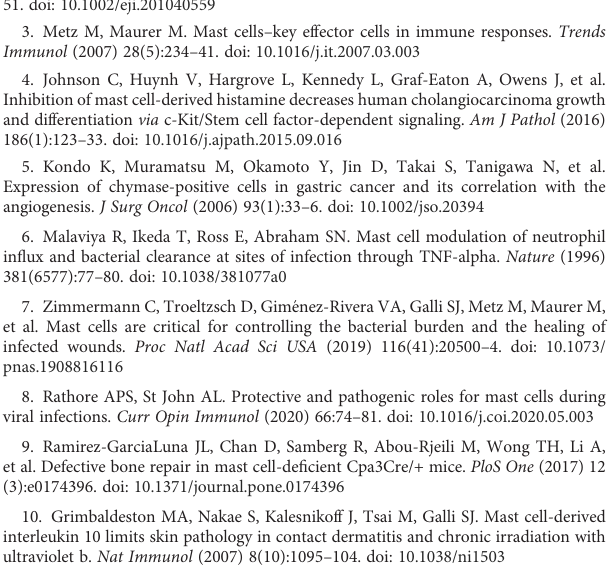
303 cells stimulated with Ag [20 ng/ml] for indicated time points todetermine externalization of LAMP1 externalization. Bar graphs shown MFIs for LAMP1 for each time point (n=3). (G) The pro-in fl ammatory cytokine production of PMC-303 cells to Ag (20 ng/ml) in comparison to other stimuli (SCF: 100 ng/ml, SCF+Ag: 100 ng/ml and 20 ng/ml, LPS: 1µg/ml, FSL-1: 1 µg/ml, IL-33: 10 ng/ml, C48/80: 10 µg/ml) was determined by IL-6 ELISA (n=3). (H) Sameexperimentasin (G) ,butsecretedamountsofTNFweredetermined by ELISA (n=3). Data are expressed as mean +SD. (C) Unpaired, two-tailed Student ’ s t -test with Welsh ’ s correction. (D – H) One-way ANOVA followed by Dunnett multiple comparisons test. Stars indicate signi fi cance within one group relative to control. p >0.05 ns, * p <0.05, ** p <0.01, *** p <0.001, **** p <0.0001. SUPPLEMENTARY FIGURE 7 GO Term analysis of the NGS data set, gating strategy and background determination for fl ow cytometry (FACS) and analysis of aneuploidy. (A) For the GO term enrichment analysis all genes regulated at least 5-fold between primary WT PMCs and PMC-306 cells were included. The top 15 GO terms with the lowest p values are depicted. GO term analysis was performed using the gene ontology knowledgebase server (http://geneontology.org/) (B – D) Gatingstrategyand backgrounddetermination for thetransformed PMC-306 line (red) and primary WT PMCs (black). (B) Left panels: Forward versus side scatter (FSC vs. SSC) gating for identi fi cation of cells of interest. FSC indicates cell size, SSC indicates cell granularity. Right panels: FSC-A vs. FCS-H gating for identi fi cation of single cells. (C, D) Unstained controls, which were not incubated with antibodies to assess background for staining against phospho-histone 3 (AL647-A, pH3) and phospho-histone H2Ax (pH2Ax, PerCP-Cy5.5-A) (C) , MKI67 (AL700-A) and DAPI (DNA content, BV421-A) (D) . (E) Representative histograms of primary WT PMCs and PMC-306 cells stained with an antibody directed against MKI67 (AL700-A) and phospho- histone H3 (pH3, AL647-A). Cellular DNA content was determined by DAPI staining (BV421-A) for assignment to the distinct cell cycle phases as follows: SubG1:< 2n DNA content; G1: 2n; S: 2-4n; G2/M: 4n; Aneuploidy: > 4n. Representative overlay of FACS-histograms of DNA content in all single cells (black) versus MKI67+ (yellow, left) or pH3+ (red, right) single cells (normalized to mode). Black arrows indicate MKI67+ and pH3+ cells with a DNA content above 4n (aneuploidy)